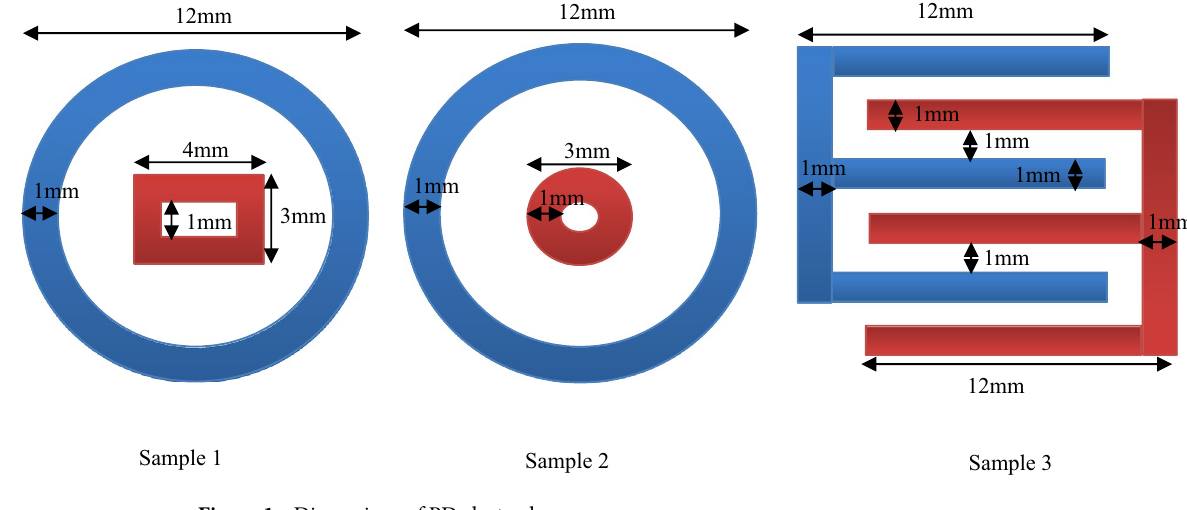
Figure 1. Dimensions of PD